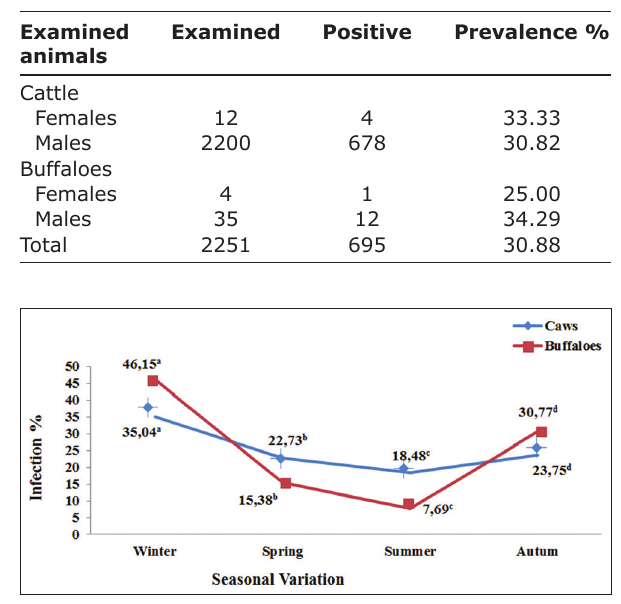
Figure-1: Seasonal liver fascioliasis condemnation rates in examined cattle and buffaloes slaughtered at the municipal abattoir of El-Kharga. Means followed by a different letter in the line are significantly different